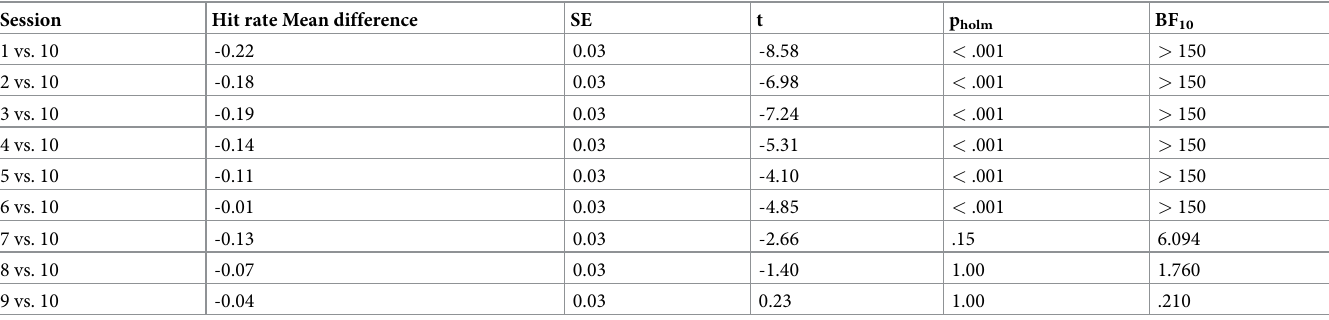
Table 2. Post-hoc comparisons between blocks 1–9 and block